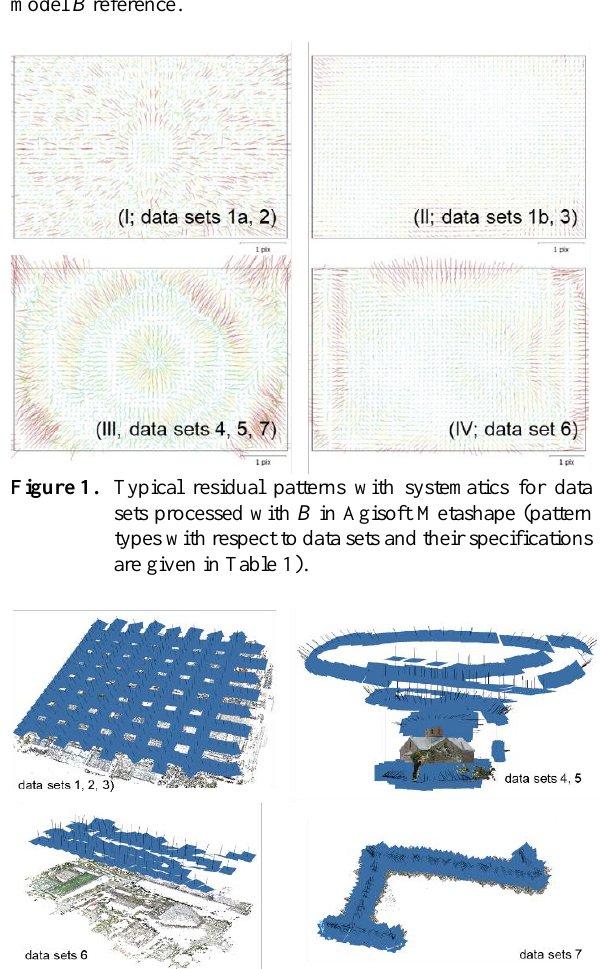
Figure 2. Overview on image configurations for the different data